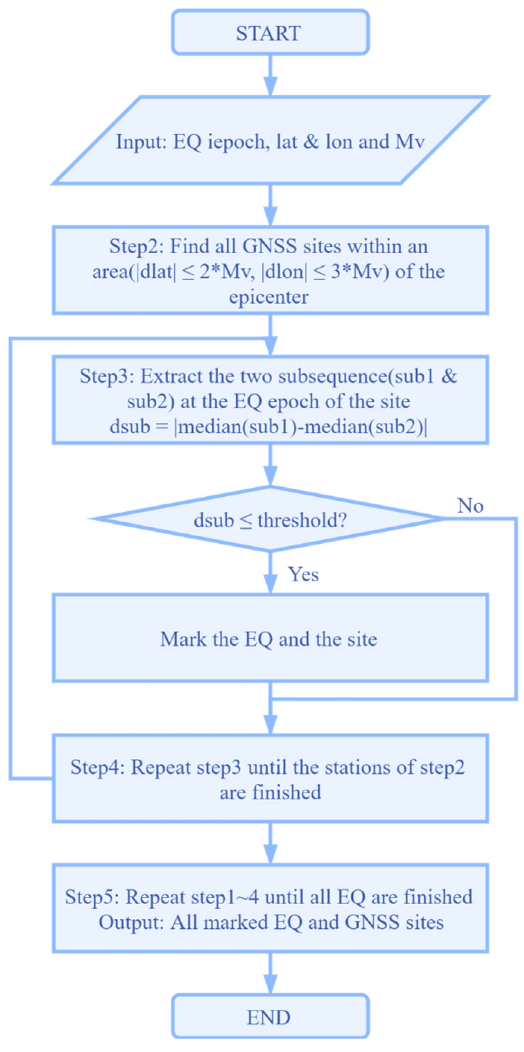
Figure 4. Selection flow of earthquakes and sites impacted by seismic